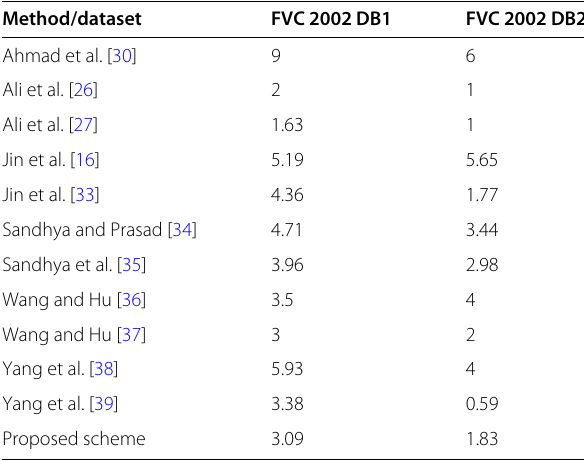
Table 3 The EER(%) comparison with some state-of-the-art methods under stolen-token scenario on FVC2002 DB1 and DB2 Method/dataset